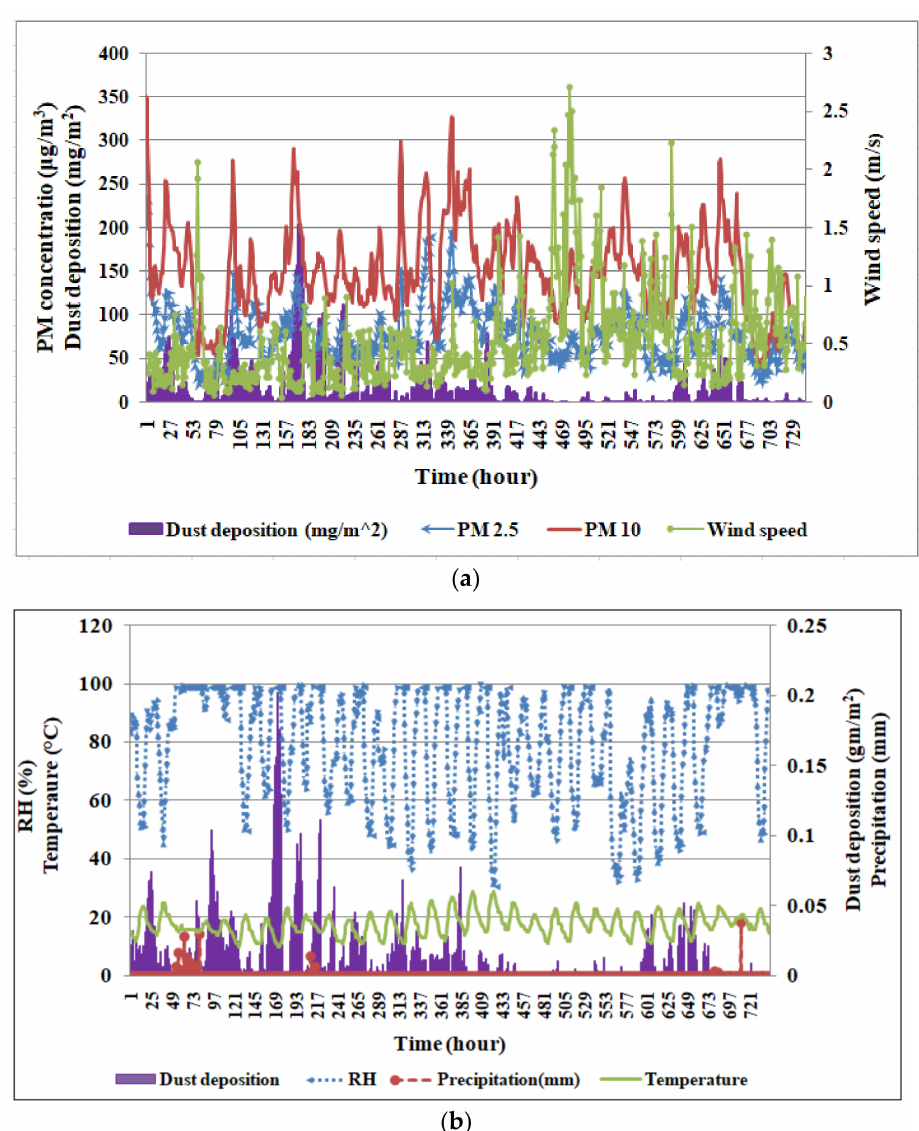
Figure 8. ( a , b ) Calculated deposited dust vis- â -vis the input weather data from 1 March 2021 to 31 March